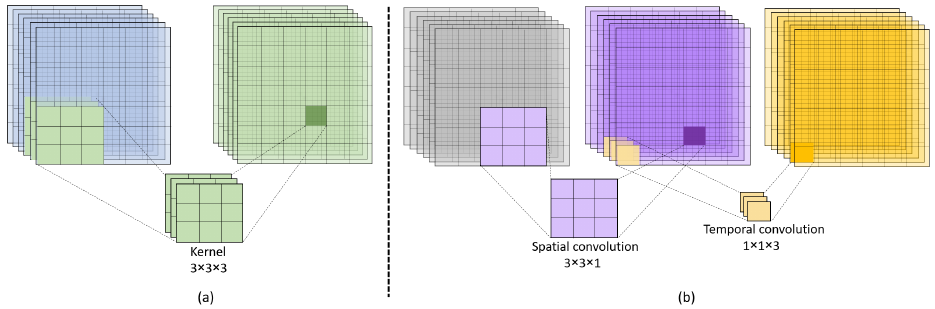
Figure 1. The visual overview of the proposed 3DCNN Teacher and 3DCNN Student network architectures.